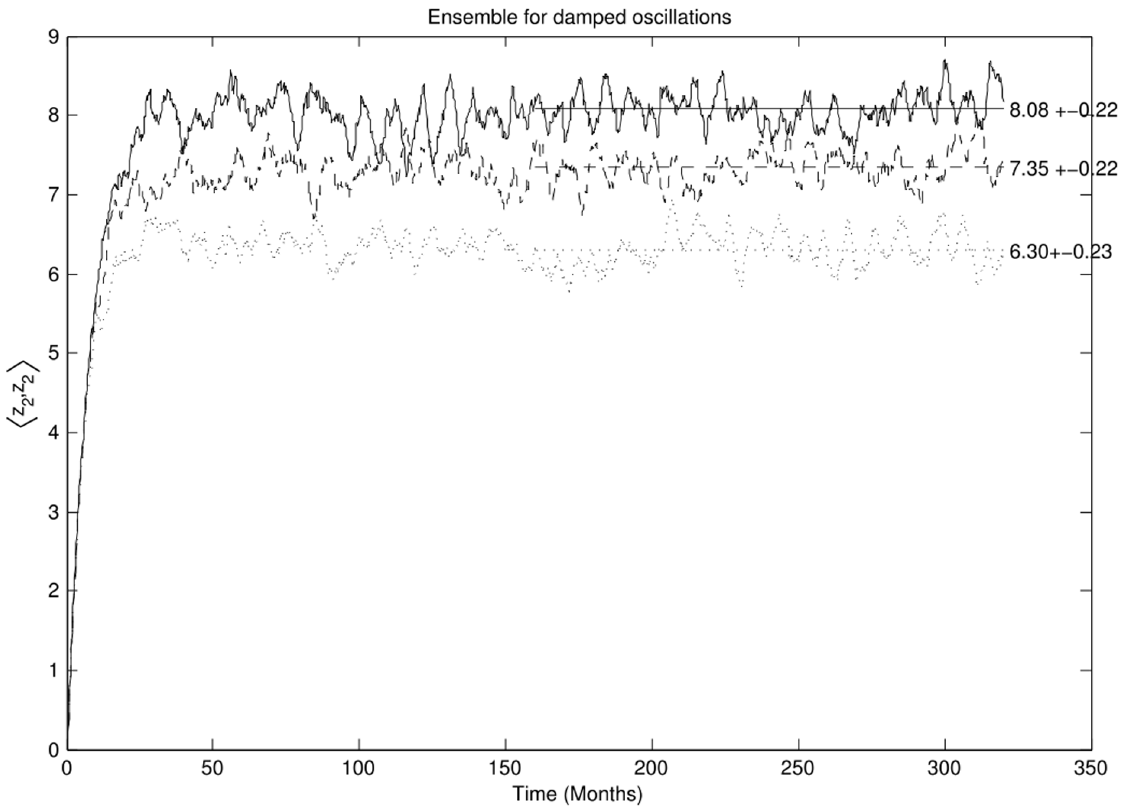
Figure 9. The evolution of the equal time variance S z 2 , z 2 T for an ensemble of 2000 simulations for the test system. The averaged variance computed after equilibration and its standard deviation is shown to the right of the figure. The solid line represents the linear system, the dashed line is the non-linear system with e ~ 0 : 01 and the dotted line is the non-linear system with e ~ 0 : 03 .